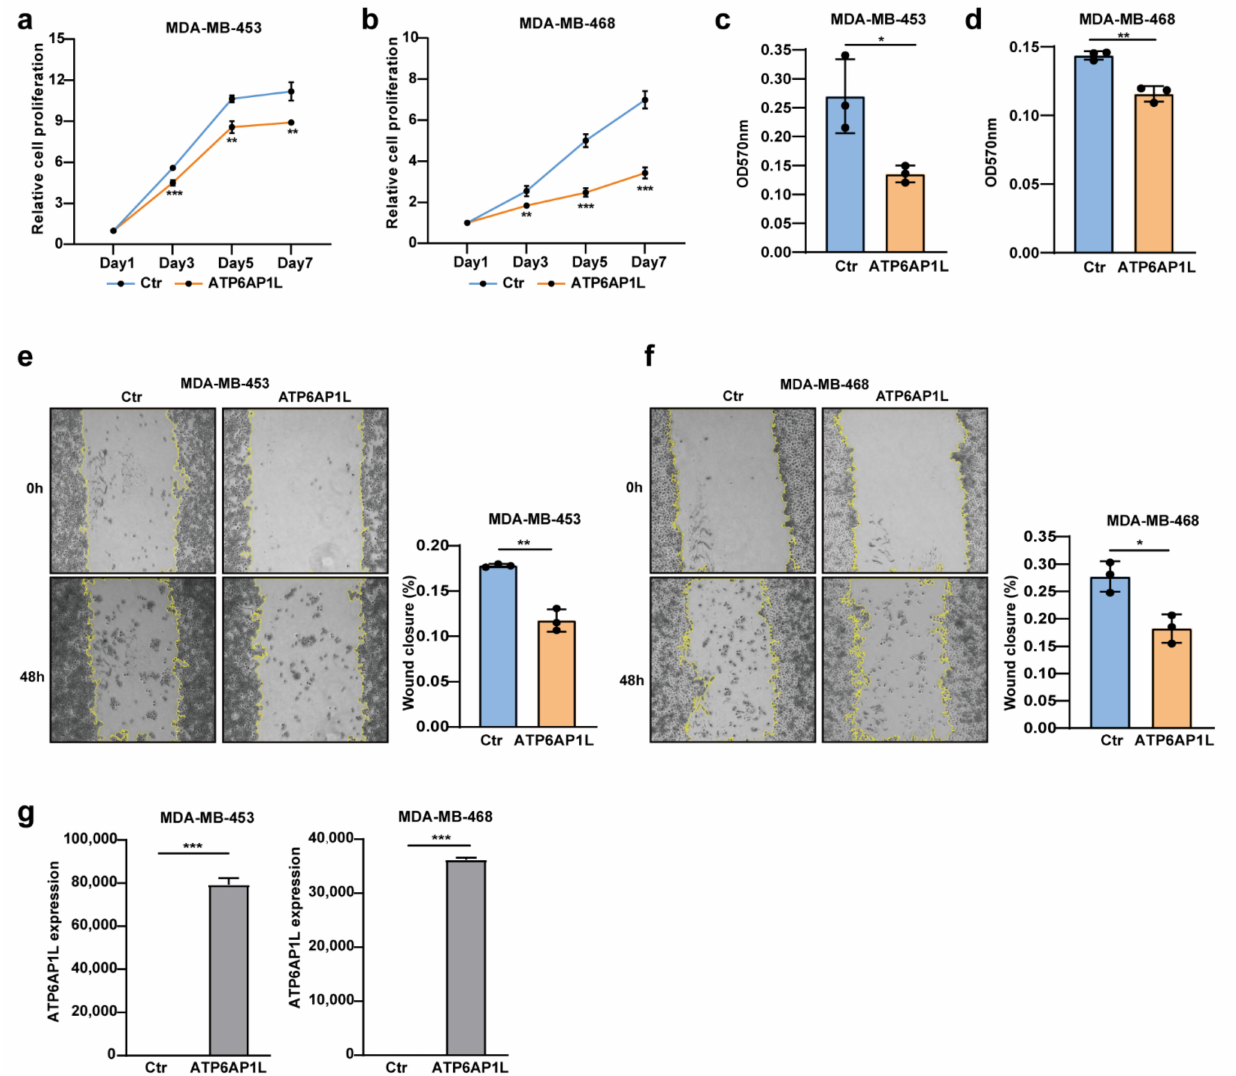
Figure 5. ATP6AP1L overexpression suppresses TNBC cell proliferation and migration. ( a , b ) Cell proliferation assay of two TNBC cell lines, MDA-MB-453 ( a ) and MDA-MB-468 ( b ), which were overexpressed with the ATP6AP1L gene by lentiviral infection. Empty vector packaged virus was used as the control. Cells numbers were measured at the indicated time points with the CCK-8 assay and represented as absorbance at 450 nm. Values are the means ± SD; ** p < 0.01, *** p < 0.001, two-tailed Student’s t -test. ( c , d ) Colony-forming assay for MDA-MB-453 ( c ) and MDA-MB-468 ( d ) cells that were overexpressed with the ATP6AP1L gene by lentiviral infection. Colonies were stained with crystal violet and quantified by reading absorbance at 570nm. Values are the means ± SD; * p < 0.05, ** p < 0.01, two-tailed Student’s t -test. ( e , f ) The wound-healing assay images for MDA-MB-453 ( e ) and MDA-MB-468 ( f ), which were overexpressed with the ATP6AP1L gene by lentiviral infection. The histogram on the right depicts the quantification of the wound closure percentage fraction. Values are the means ± SD; * p < 0.05, ** p < 0.01, two-tailed Student’s t -test. ( g ) ATP6AP1L overexpression in MDA-MB-453 and MDA-MB-468 cells was analyzed by qPCR. Values are the means ± SD; *** p < 0.001, two-tailed Student’s t